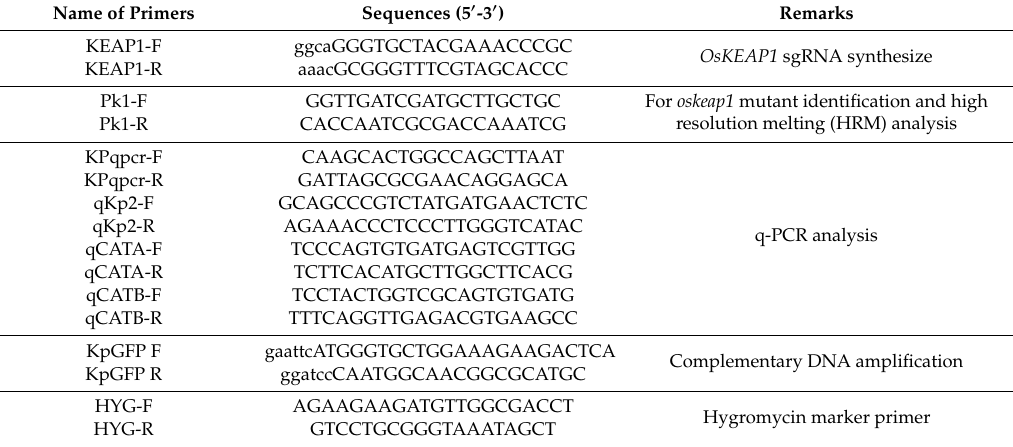
Table 1. List of primers used in this